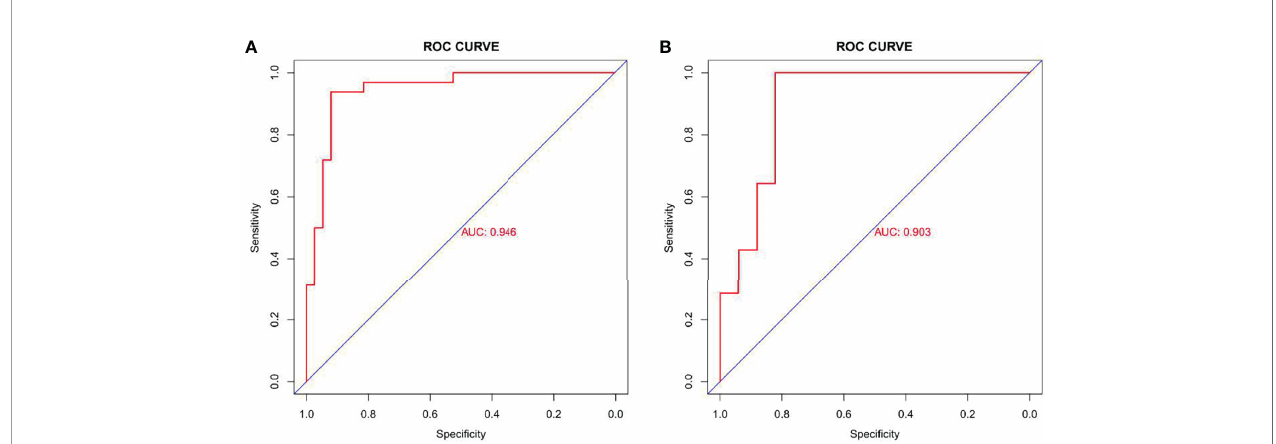
FIGURE 4 | Receiver operating characteristic (ROC) curves of radiomics signature in training cohort (AUC: 0.946, 95% CI: 0.919-0.973) (A) and validation cohort (AUC: 0.903, 95% CI: 0.847-0.959) (B) . AUC, area under the curve; 95% CI, 95% con fi dence